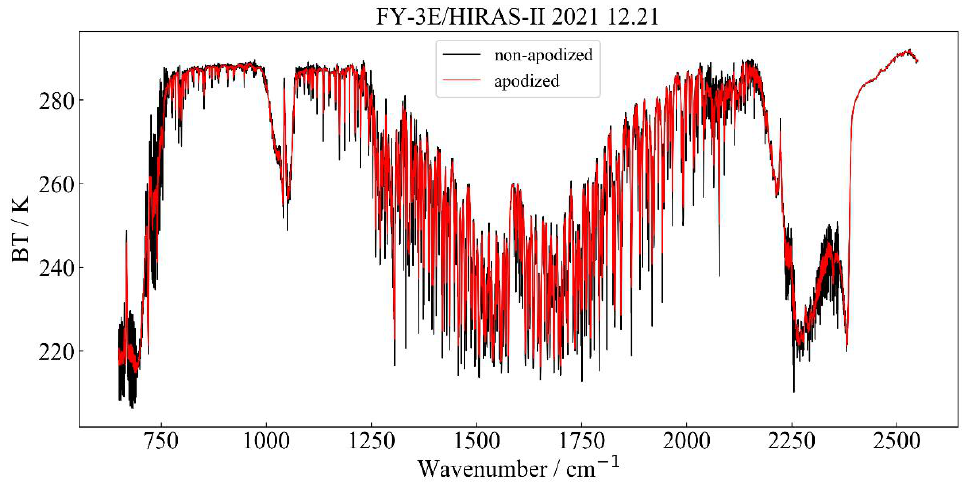
Figure 1. Comparison of spectral brightness temperature before and after apodization.